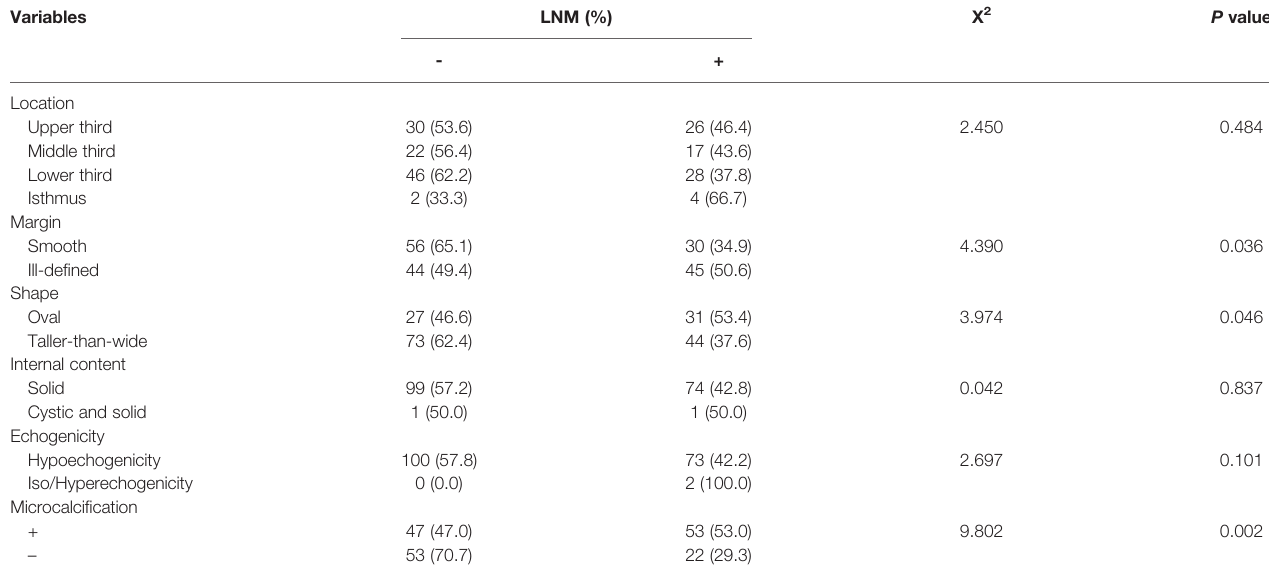
TABLE 2 | Association between LNM and US characteristics of PTCs with the BRAF V600E mutation. Variables LNM (%) X 2 P